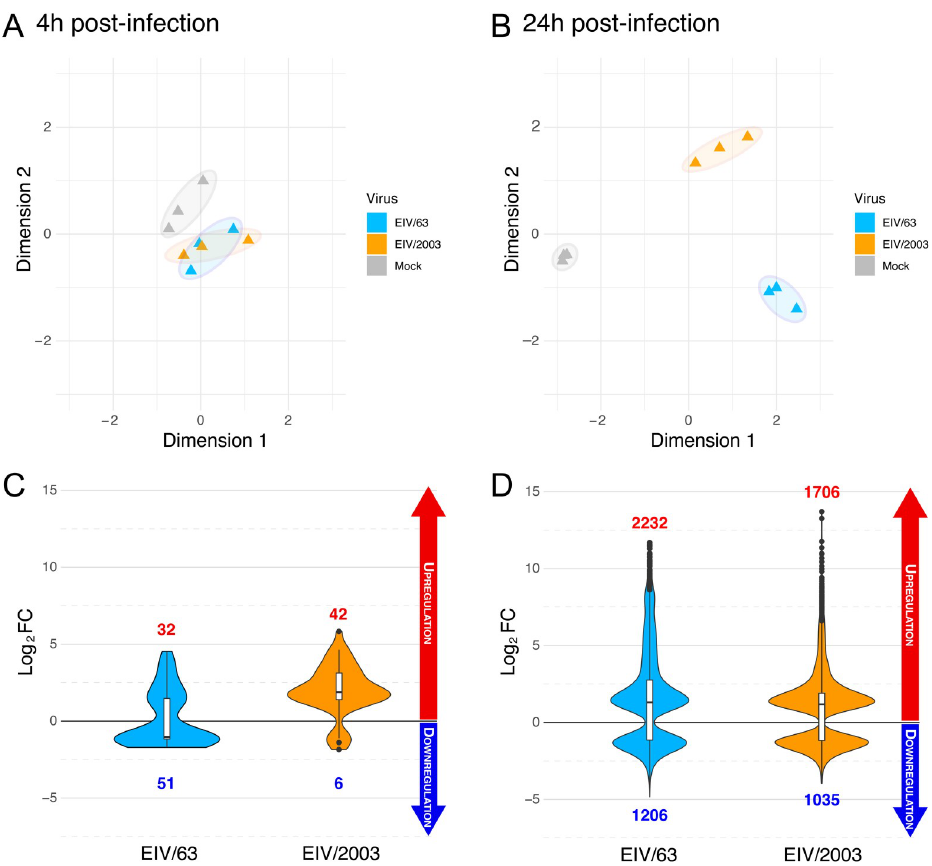
Fig 2. Overview of EIVs transcriptomes in E.Derm cells. (A-B) Multidimensional scale plots of transcriptomes of E. Derm cells infected with EIV/63 (cyan), EIV/2003 (orange), or mock-infected (grey) at 4 hpi (A) or 24 hpi (B). Interpoint distance correlates with divergence in transcriptomic profiles. (C-D) Violin plots of differentially expressed genes (DEGs) (p < 0.05; |Log 2 FC| > 1) identified in E.Derm cells infected with EIV/63 (cyan) or EIV/2003 (orange) compared to mock-infected cells at 4 hpi (C) or 24 hpi (D). The number of upregulated and downregulated genes in each condition is shown in red and blue, respectively. Data presented here summarise three independent